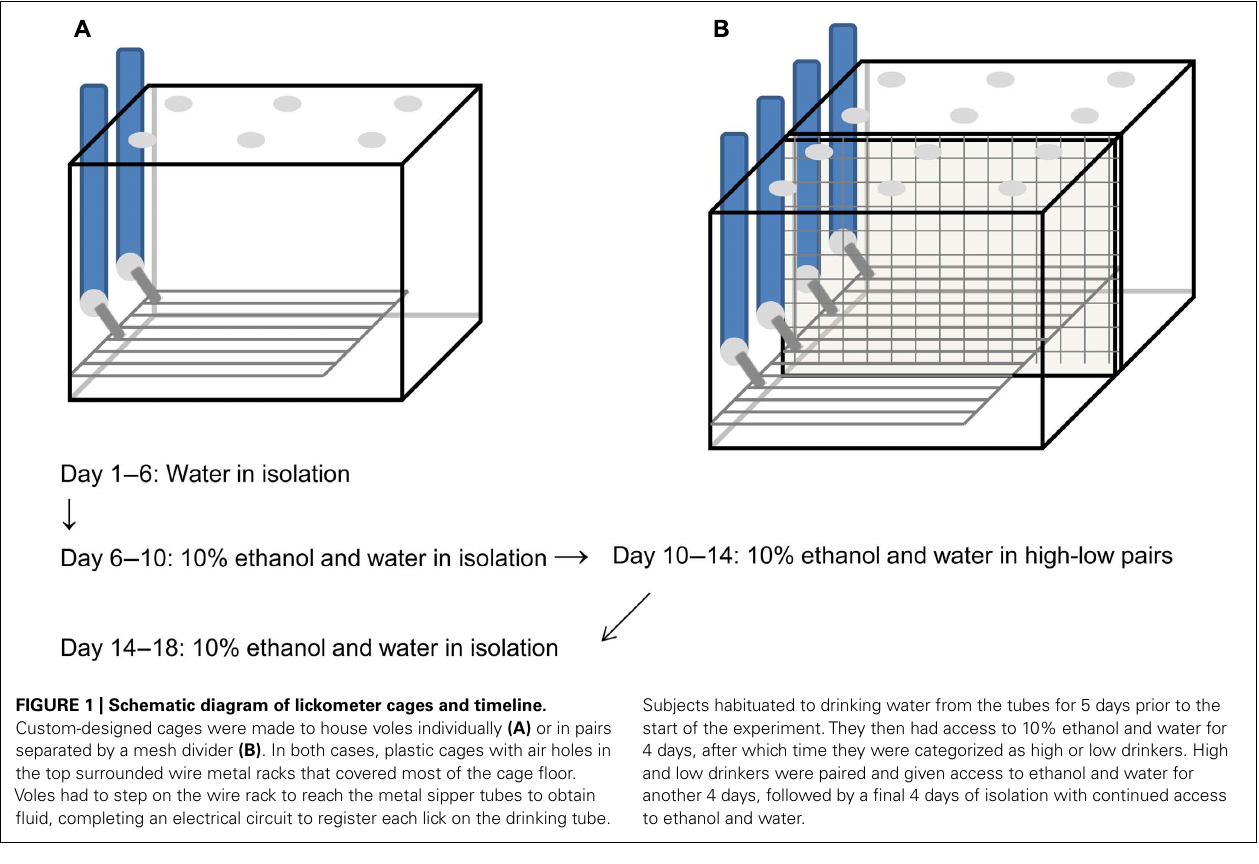
Subjects habituated to drinking water from the tubes for 5 days prior to the start of the experiment.They then had access to 10% ethanol and water for 4 days, after which time they were categorized as high or low drinkers. High and low drinkers were paired and given access to ethanol and water for another 4 days, followed by a final 4 days of isolation with continued access to ethanol and